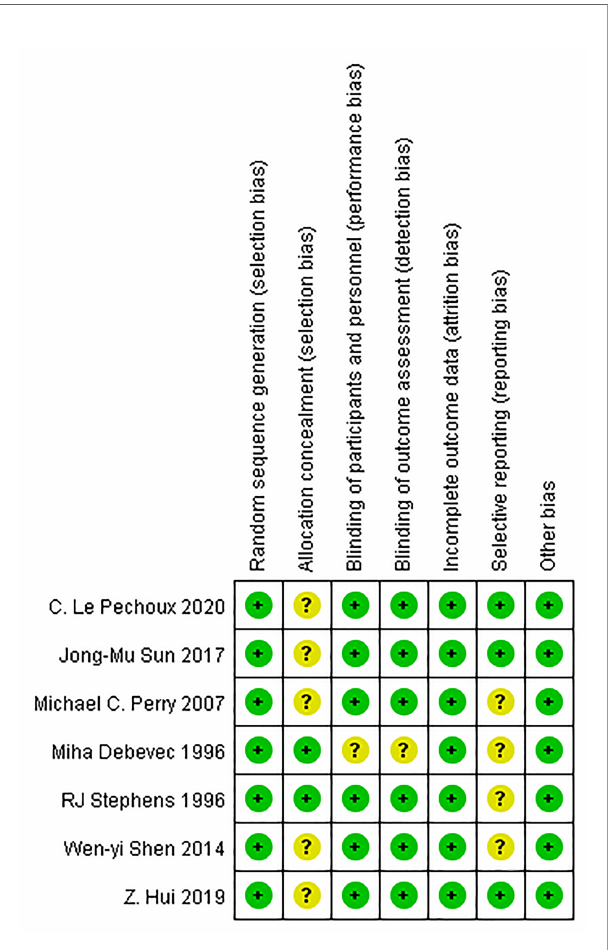
FIGURE 2 | Risk of bias assessment of included